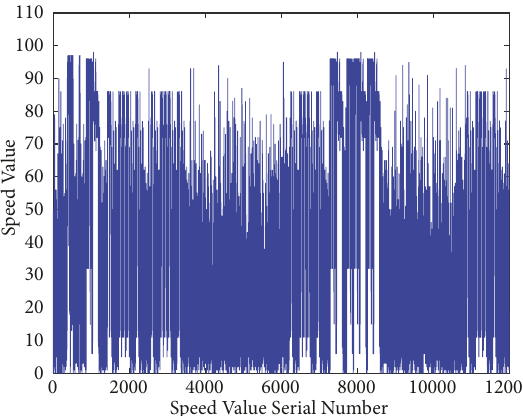
Figure 1: Velocity curve before data compression.